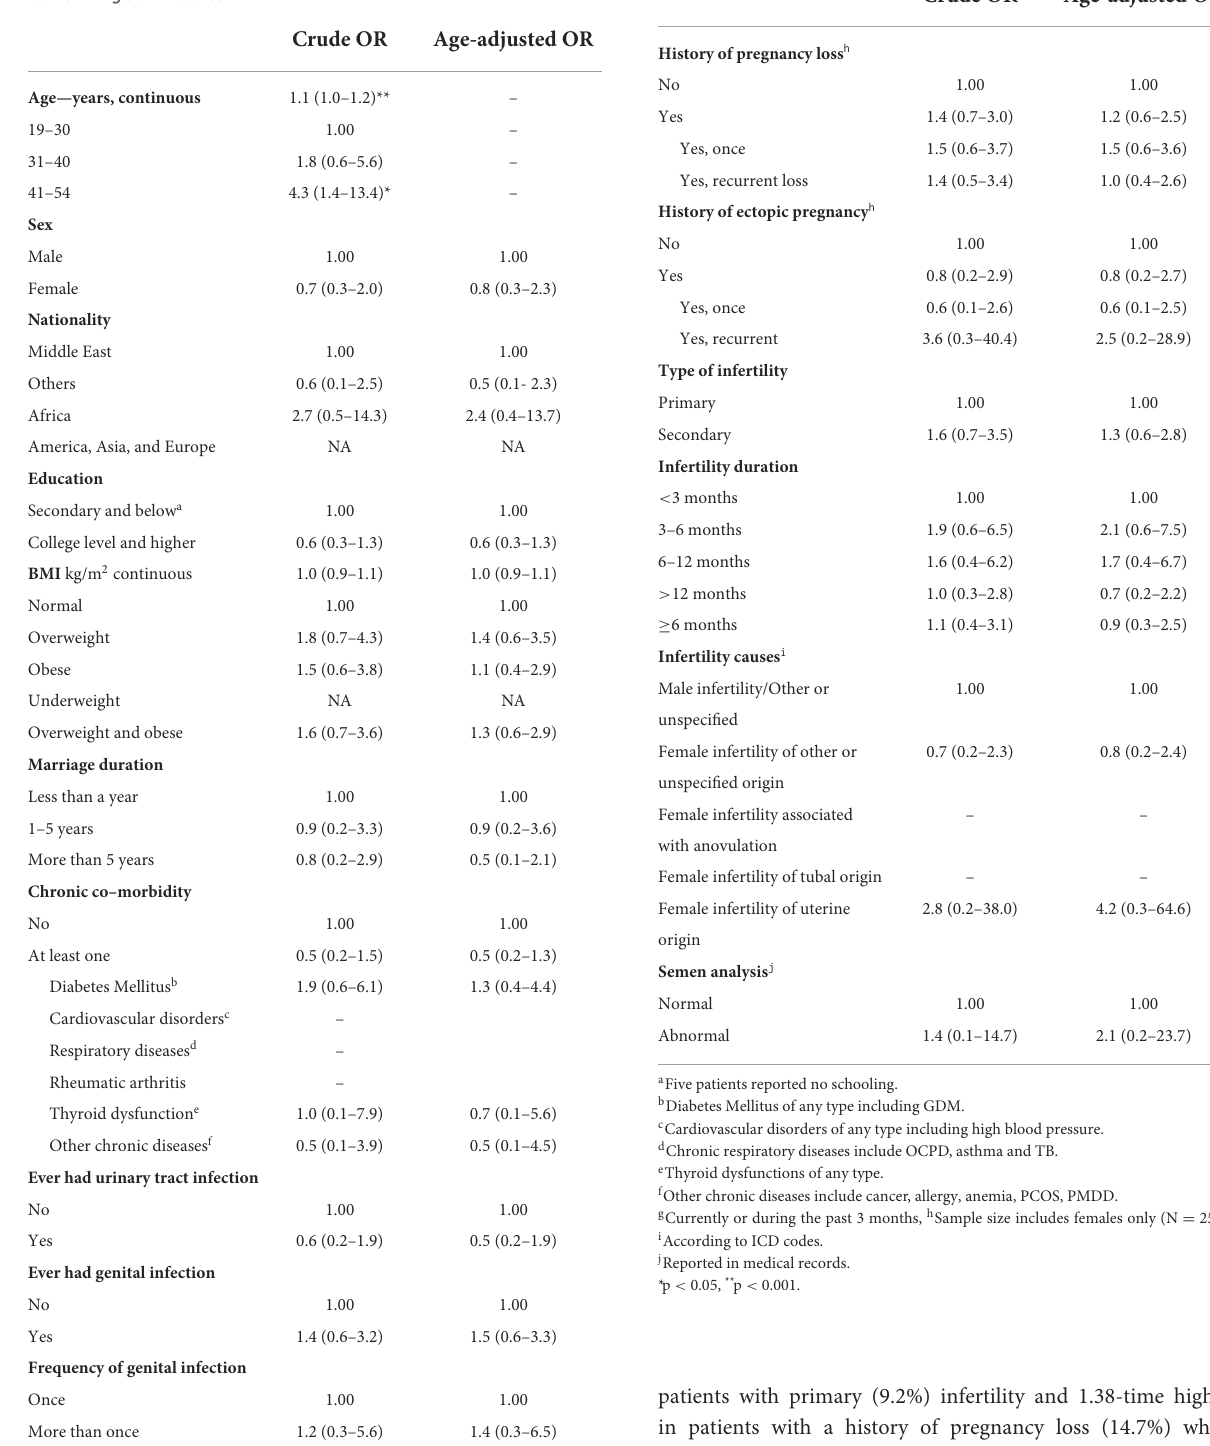
TABLE 3 The crude and adjusted association between the measured characteristics of fertility clinics’ attendees with being of seropositive to HSV-2 IgG antibodies.